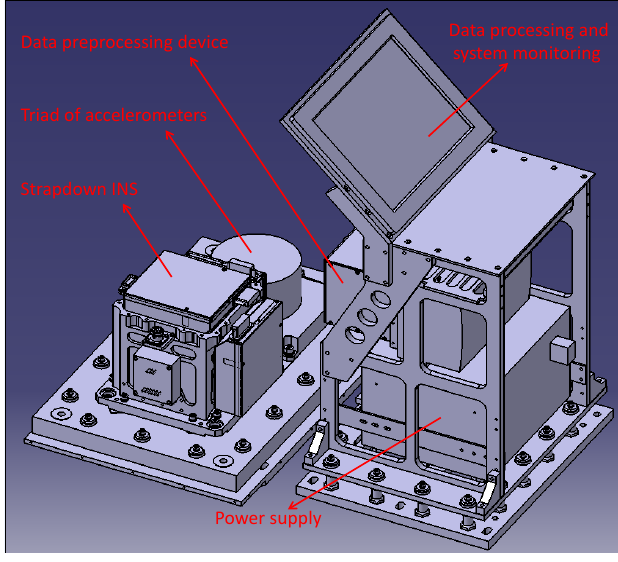
Figure 2. Primary components of the airborne gravimeter SGA-WZ including two cabinets: cabinet of SDINS and cabinet of data recording and system monitoring